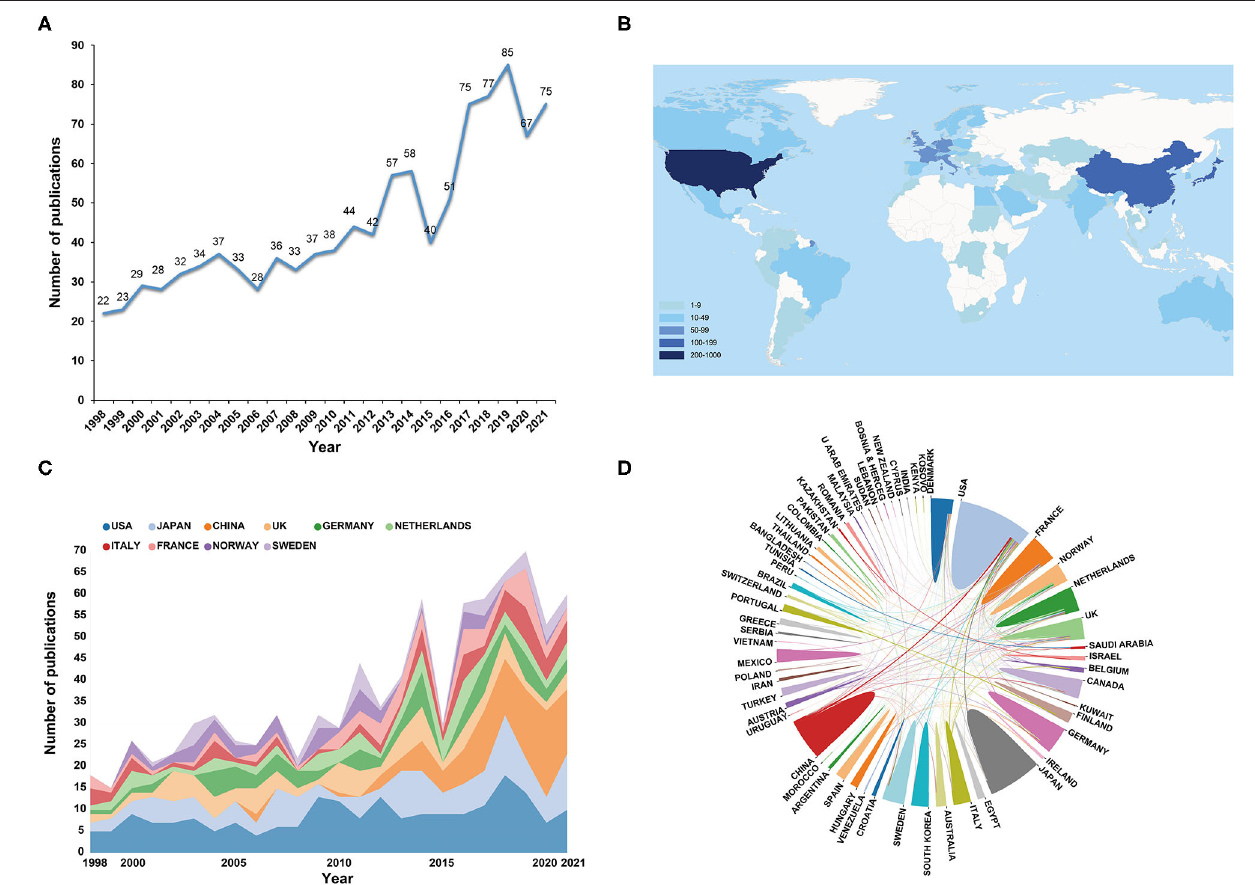
FIGURE 2 | (A) The annual number of publications regarding osteoporosis in RA research from 1998 to 2021. (B) A world map depicting the contribution of each country based on publication counts. (C) The annual number of publications in the top 10 most productive countries from 1998 to 2021. (D) International collaboration analysis among different